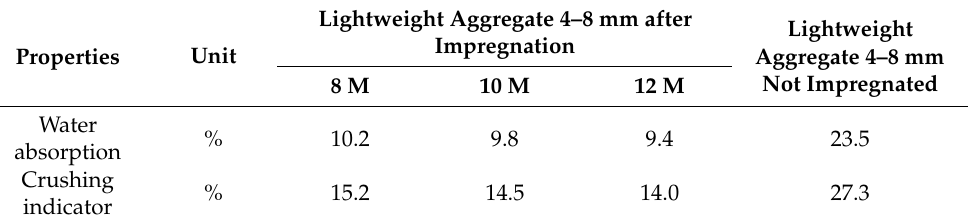
Table 5. The properties of the lightweight artificial aggregate with the 4–8 mm